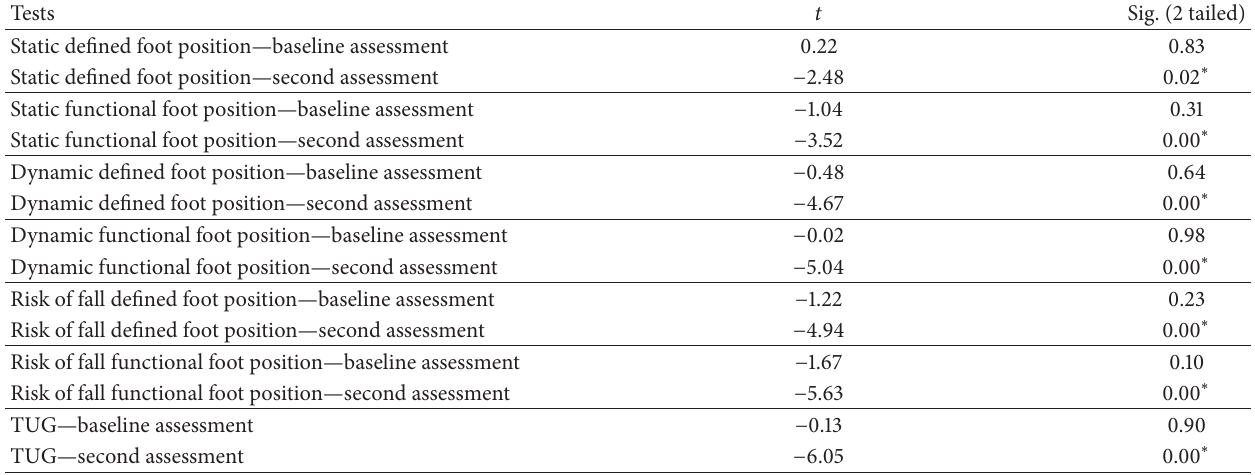
Table 3: Independent sample 𝑡 test